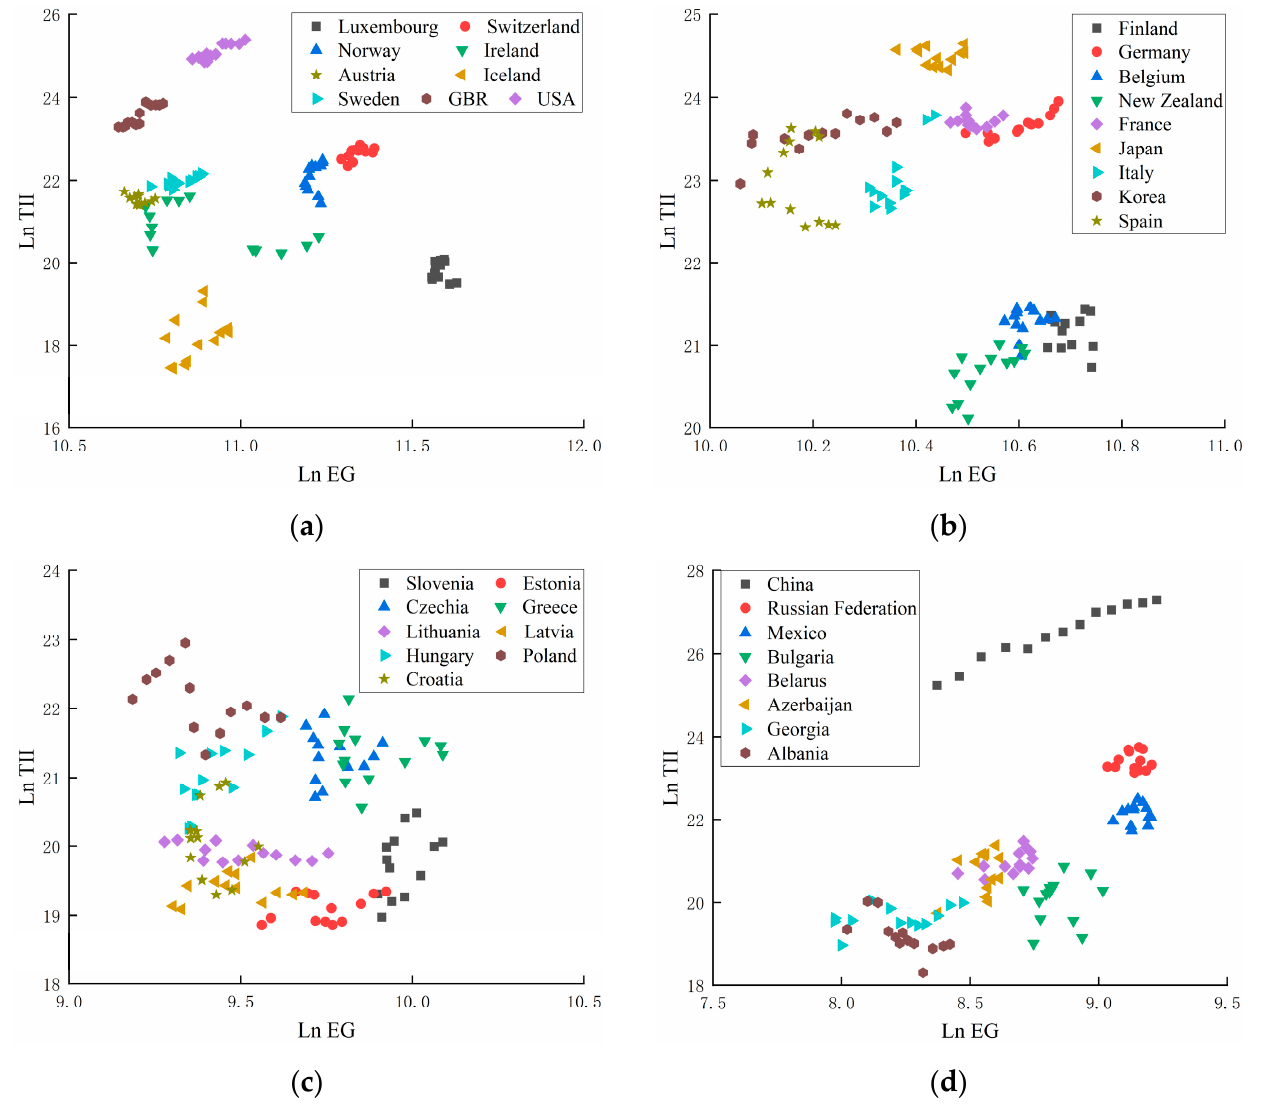
Figure 3. TII and EG in OECD+ countries with different income levels from 2007 to 2019. ( a ) The first group of high-income OECD+ countries. ( b ) The second group of high-income OECD+ coun- tries. ( c ) The third group of high-income OECD+ countries. ( d ) The group of upper-middle-income OECD+ countries.